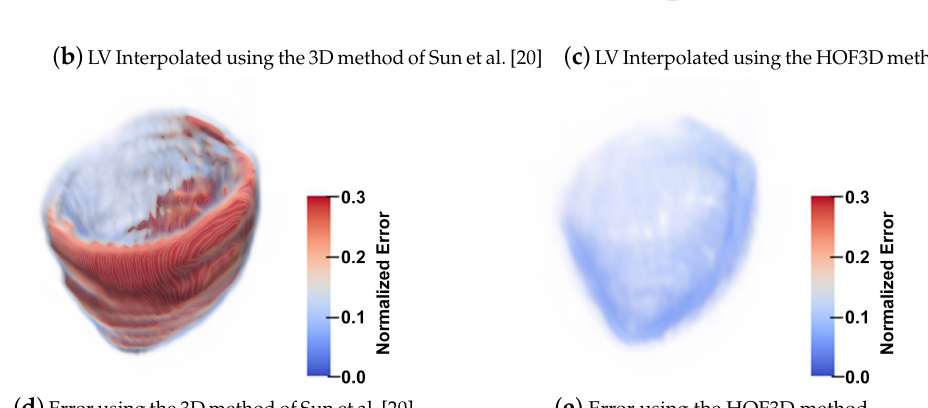
Figure 17. Interpolation Errors for the left ventricle at